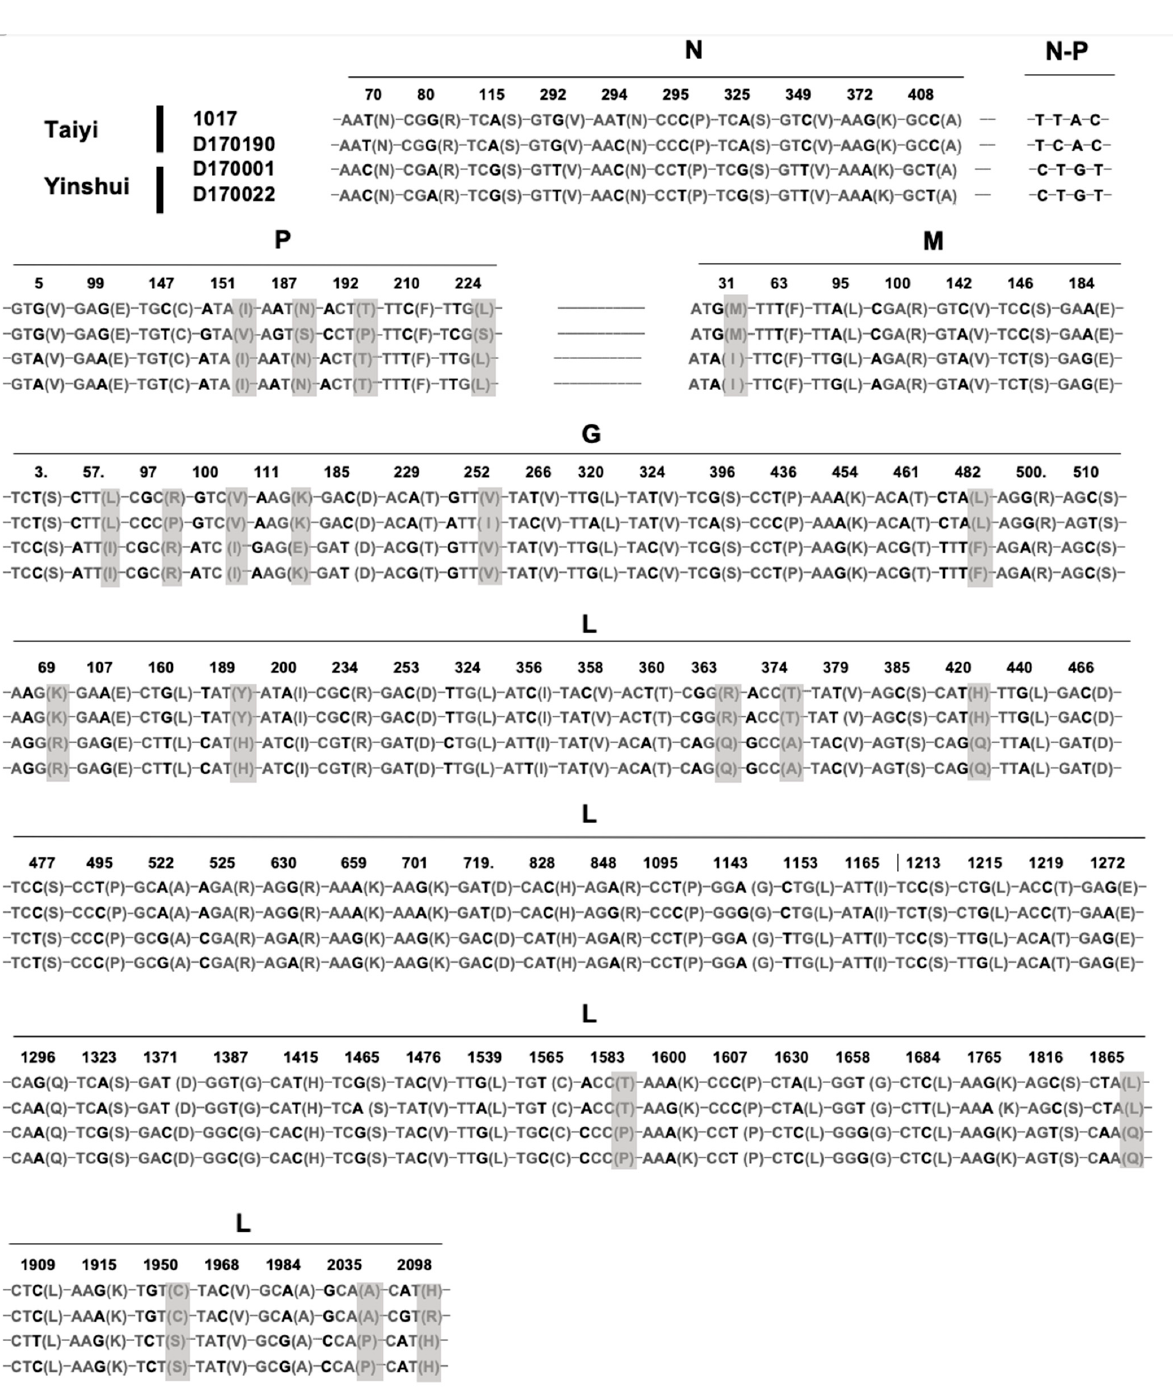
Figure 5. Identification of the nucleotide and amino acid mutations between the four isolates (1017, D170001, D170022, and D170190) of putative YSBV species. The nucleotide mutations are indicated in bold and the amino acid mutations in grey.